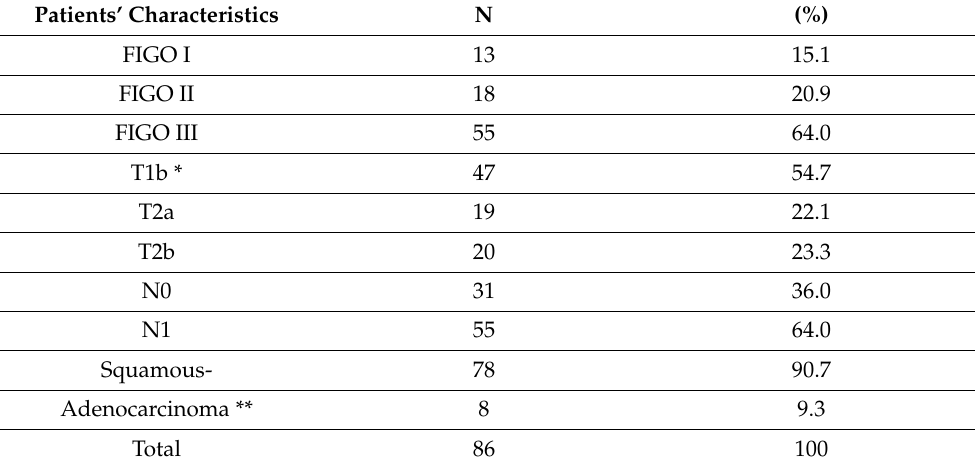
Table 1. Characteristics of